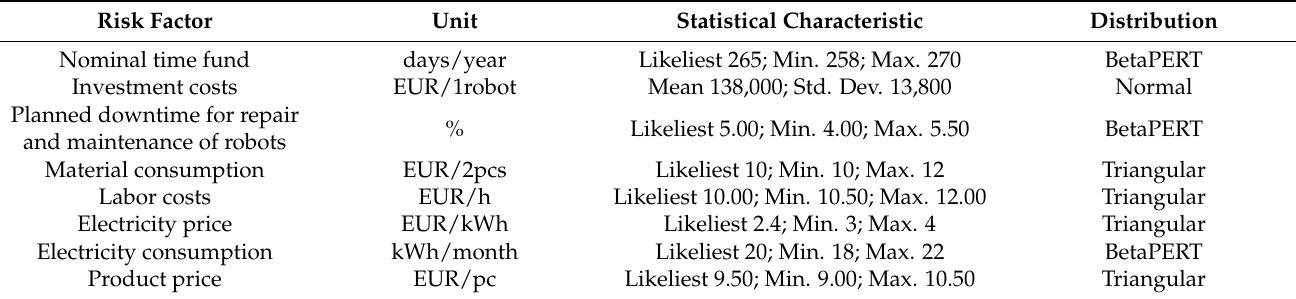
Table 7. Probability distributions and statistical characteristics of risk